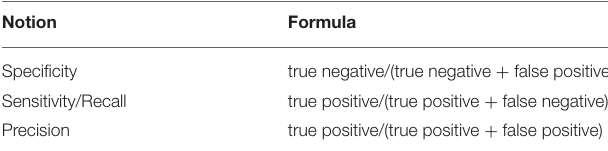
TABLE 1 | Metrics used to create ROC